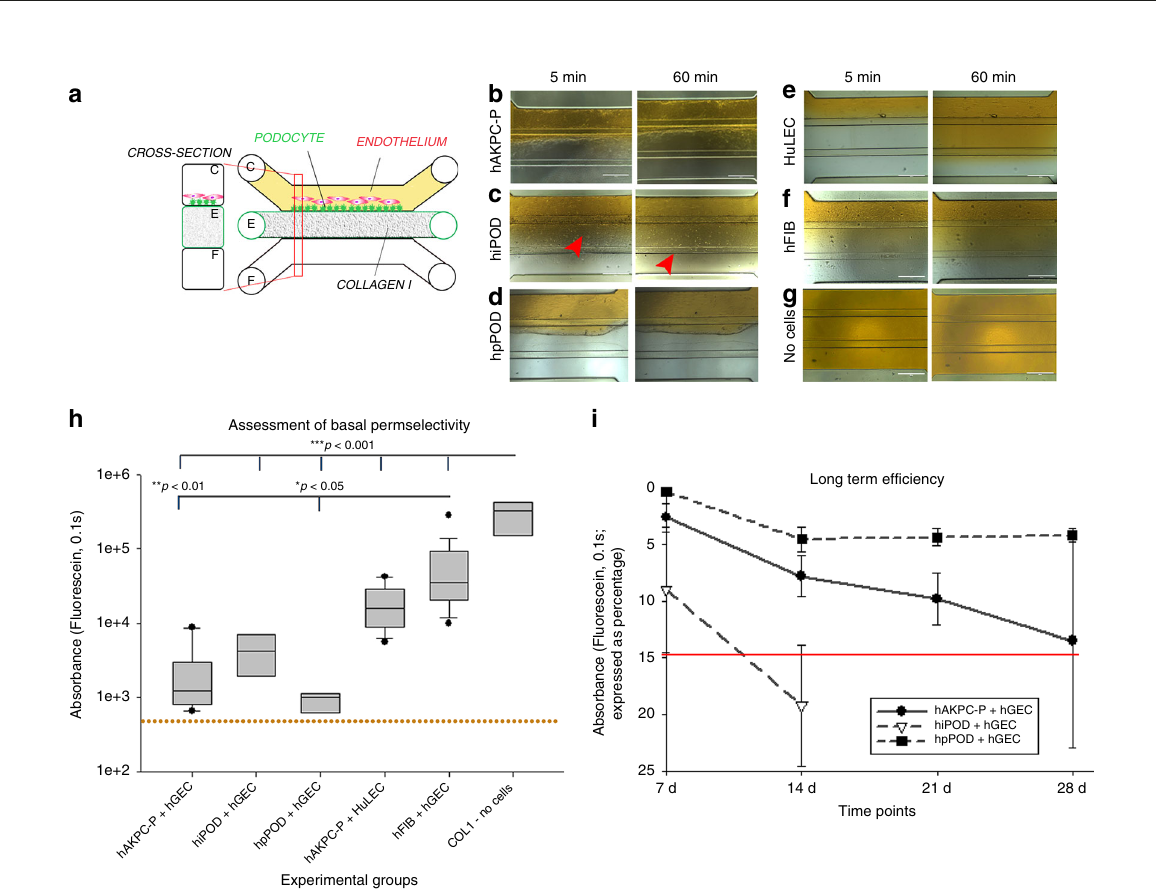
Fig. 2 Seeding of endothelial cells and podocytes in Organoplates TM and generation of the GOAC. a Representation of seeded hGEC in Organoplate TM . b Confocal Z-stack image showing formation of capillary-like structure. Phaseguide TM components (yellow lines) can be easily identi fi ed within the panel. Channel E is fi lled with collagen I (visible thanks to auto fl uorescence in the red channel) while channel C con fi rms formation of a capillary-like structure by a continuous monolayer of hGEC (stained with CD31, Alexa-555, red). c , d confocal image for CD31 (Alexa-555, red, c ) and for WGA (Rhodamine, red, d ) in hGEC after 28 days of culture. e Representation of seeded podocytes in Organoplate TM . f – h Confocal image for nephrin (NPHS1-FITC, green) in hAKPC- P ( f ), in hiPOD ( g ), and hpPOD ( h ) seeded on the channel C after 28 days of culture. Nephrin expression is present on the level of cell – cell contact (arrow). i Representation of seeded of podocytes and hGEC in Organoplate TM . j – l Confocal image for nephrin (NPHS1-FITC, green) and CD31 (Alexa-555, magenta) in hAKPC-P + hGEC chip ( j ), in hiPOD + hGEC chip ( k ), and hpPOD + hGEC chip ( l ) after 28 days of culture. All three podocyte lines form a continuous layer, distinguishable from the hGEC layer. m Representation of a GBM-like structure in Organoplate TM . n – v Confocal image for COL4A4 (Alexa-555, red), for COL4A12 (Alexa-555, red), and for LAMA5A (Alexa-555, red) in hAKPC-P + hGEC chip ( n – p ), in hiPOD + hGEC chip ( q – s ), and hpPOD + hGEC chip ( t – v ) after 28 days of culture. hAKPC-P + hGEC chip and hpPOD + hGEC chip show de novo generation of GBM, which is less evident in the hiPOD + hGEC. Nuclei are stained with DAPI (blue). All pictures: scale bar = 50 µ m; except bottom panel in f – l with scale bar = 25 µ m bar. w – y Western blot analysis for COL4A3 (25 kDA, monomeric form; 50 kDA, dimeric form), LAMA5 (70 kDa), and beta actin (40 kDa) in hAKPC-P + hGEC ( w ), hiPOD + hGEC ( x ), and hpPOD + hGEC ( y ) GOAC. Positive control: human whole-kidney lysate. Western blot images were cropped to show the relevant bands and improve clarity. Uncropped and unprocessed scans for western blotting analysis are provided in Supplementary Fig. 11